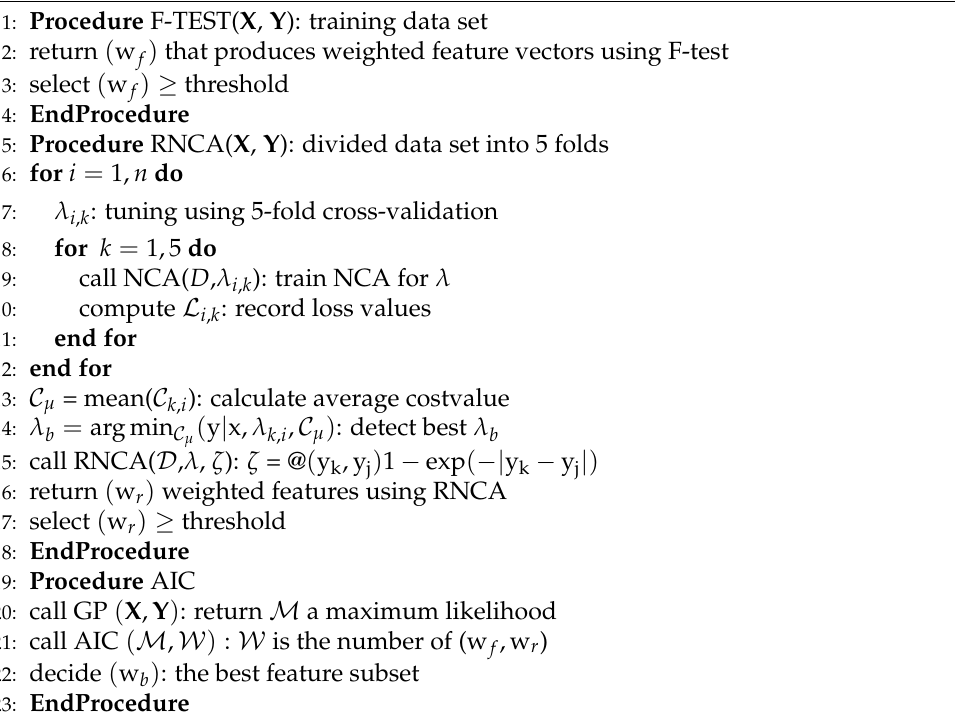
Algorithm 1 Hybrid F-test and RNCA using AIC based on GP